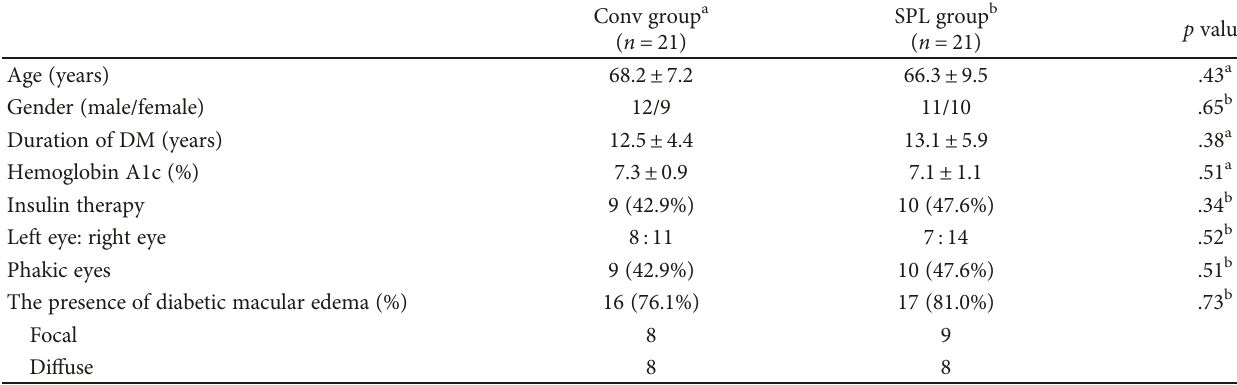
Table 2: Baseline characteristics at the time of